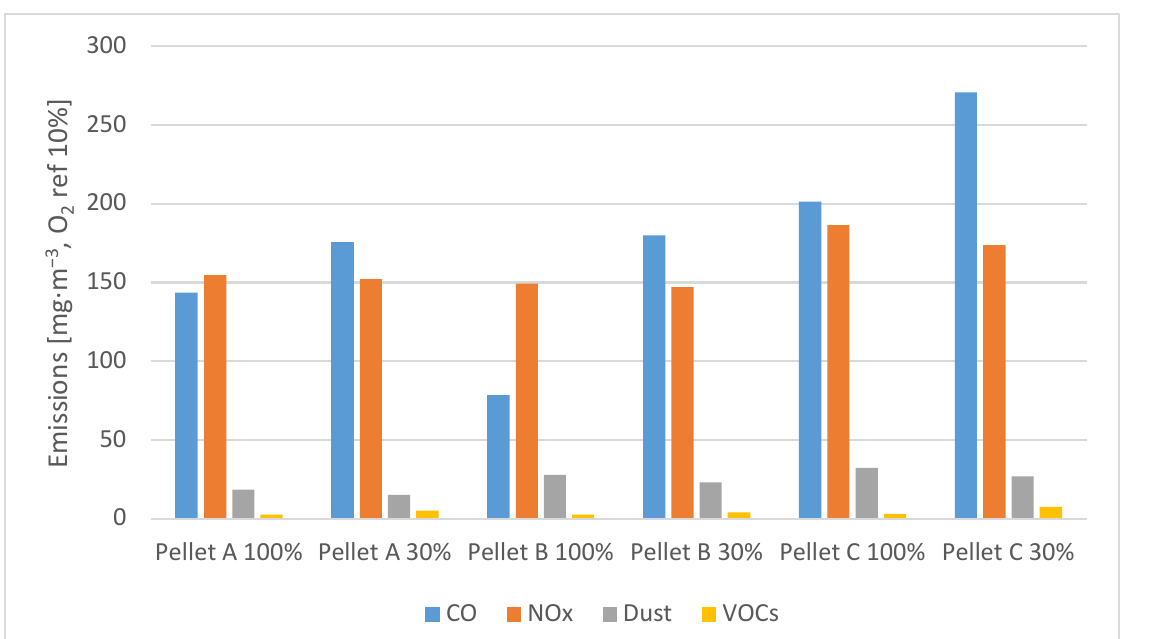
Figure 11. Comparison of average statistical emissions from the combustion of three types of wood pellets in experimental burners.